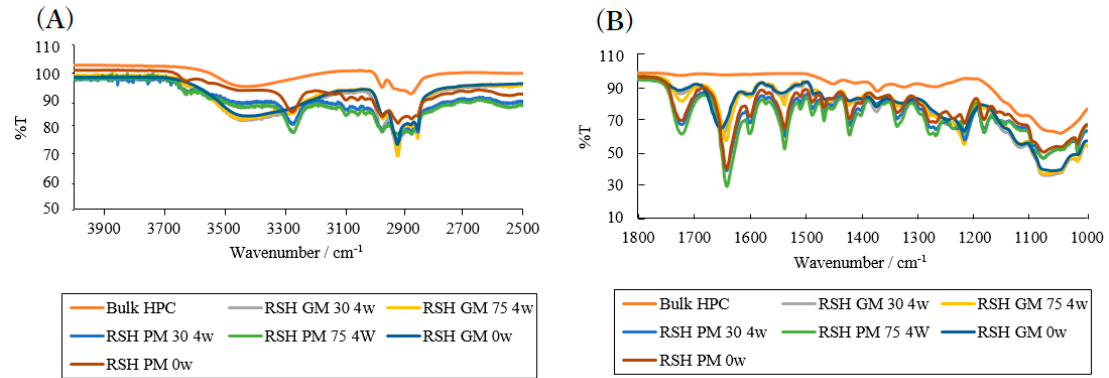
Figure 9. Attenuated total reflection-mid-infrared spectra of bulk HPC and stored RB, SDS, and HPC-SSL (RSH) samples. RSH samples were stored in RH 30% and RH 75%. RB, SDS, and PVP samples stored for 4 weeks in RH 30% and RH 75%. The two regions of 4000 to 2500 cm − 1 ( A ) and 1800 to 1000 cm − 1 ( B ). RH; relative humidity. RB; rebamipide. SDS; sodium dodecyl sulfate. HPC-SSL; SSL grade hydroxypropyl cellulose. PVP; polyvinylpyrrolidone. w; weeks.